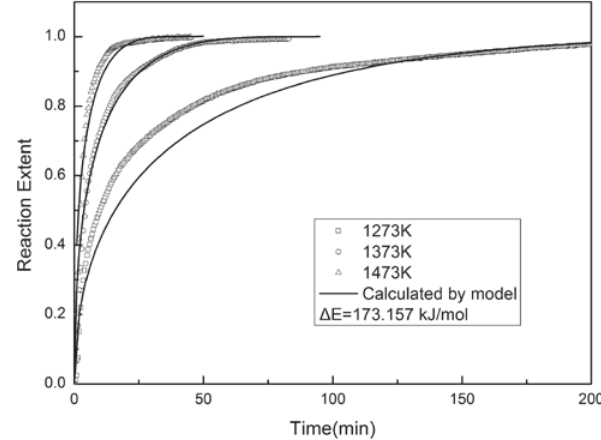
Fig. 7: A comparison between experimental data and theoretical predictions from Jander model at different temperatures